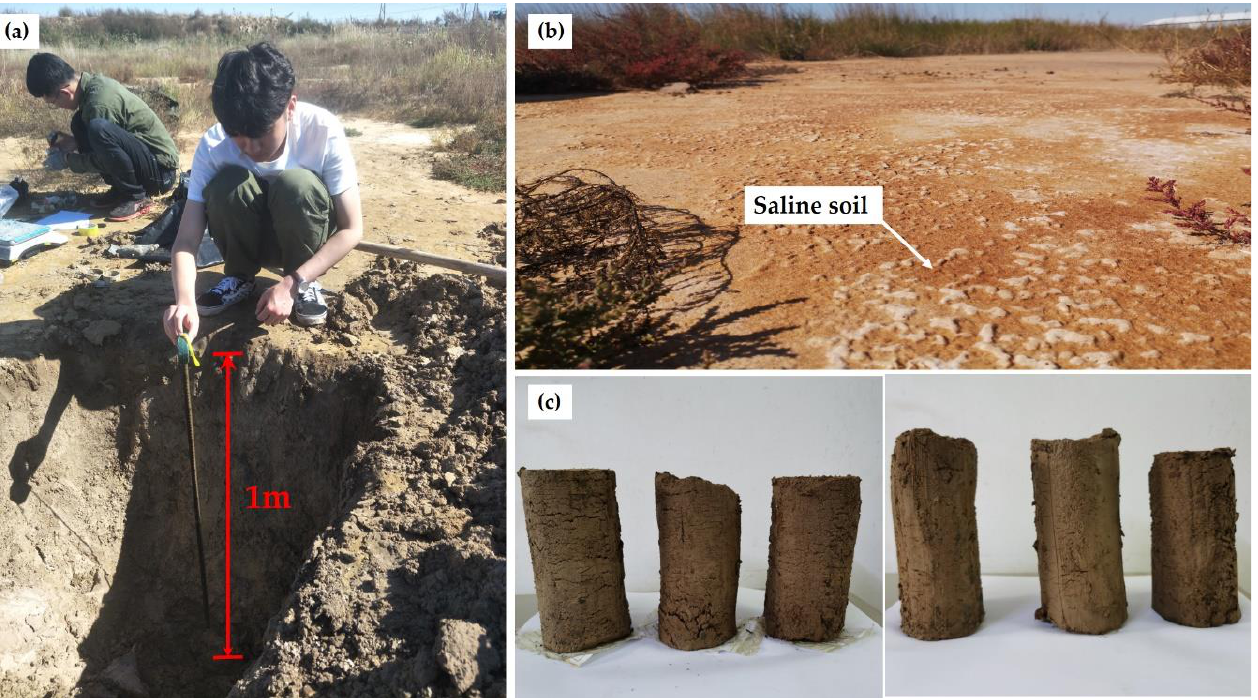
Figure 1. Natural soil specimens were obtained from sampling sites. Notes: ( a ) Saline soil site; ( b ) Surrounding environment; ( c ) Nature soil specimen. Table 1. The mineral content of natural saline